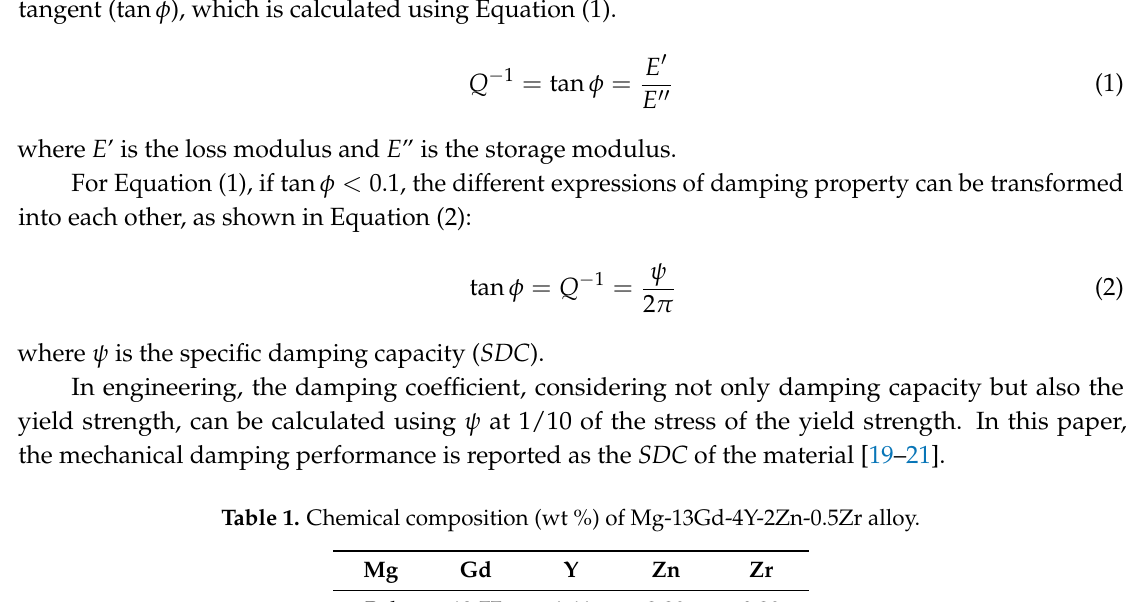
Table 1. Chemical composition (wt %) of Mg-13Gd-4Y-2Zn-0.5Zr alloy.